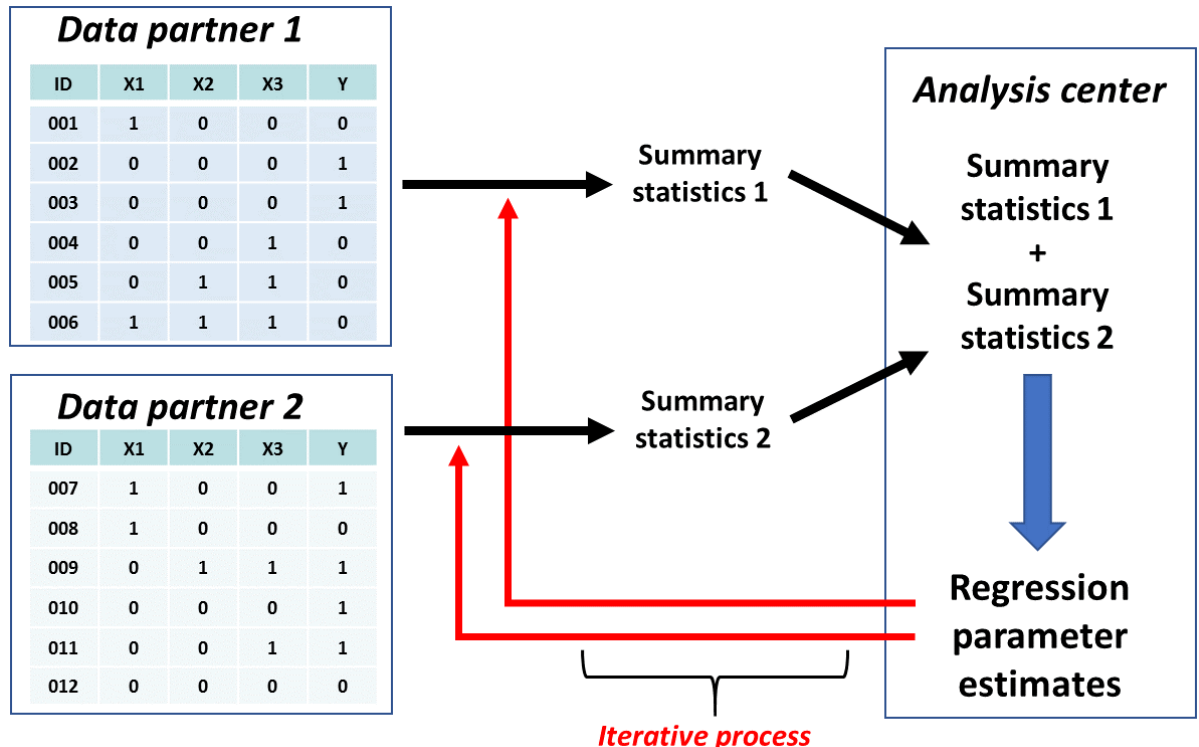
Figure 1. Distributed regression analysis with horizontally partitioned